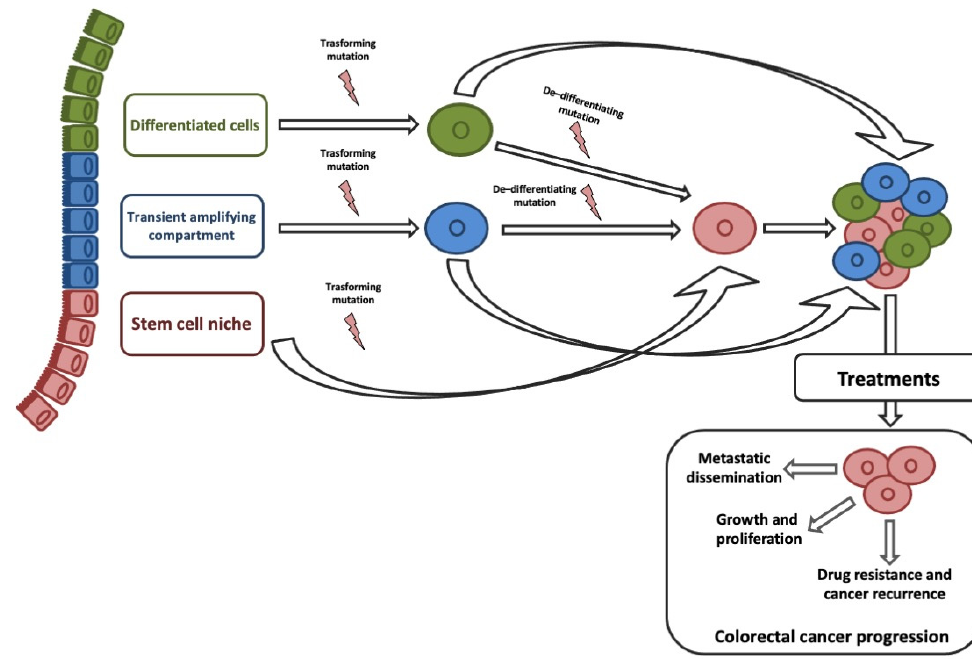
Figure 1. Origin of colorectal cancer stem cells (CCSC) and their role in tumor progression. Colorectal cancer (CRC) cells may originate from intestinal stem cells (ISCs), cells in transit, and terminally differentiated cells gaining a transforming mutation. A single mutation in an ISC could originate a CCSC; at least one transforming, and one de-differentiating mutation would be needed to transform a transit-amplifying (TA) or differentiated cell into a CCSC.